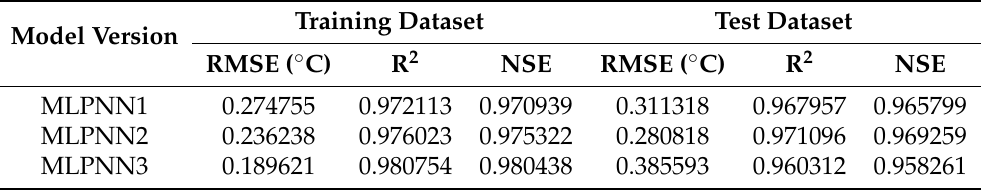
Table 7. Performances of Multilayer Perceptron Neural Network in modeling water temperature (WT: ◦ C), MLPNN1: only one input variable (DOY), MLPNN2: with two input variables (DOY and Flow), MLPNN3: with all input